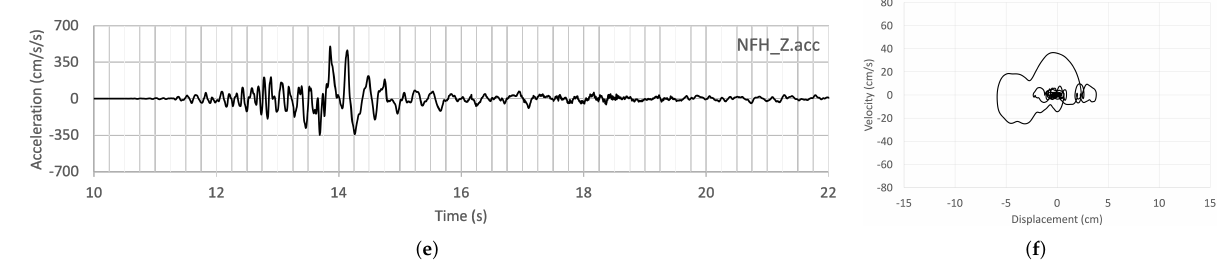
Figure 7. Acceleration time histories ( a , c , e ) and phase plane diagrams ( b , d , f ) at the base of the aggregate in the ( a , b ) X direction (see Figure 4); ( c , d ) Y direction; ( e , f ) Z